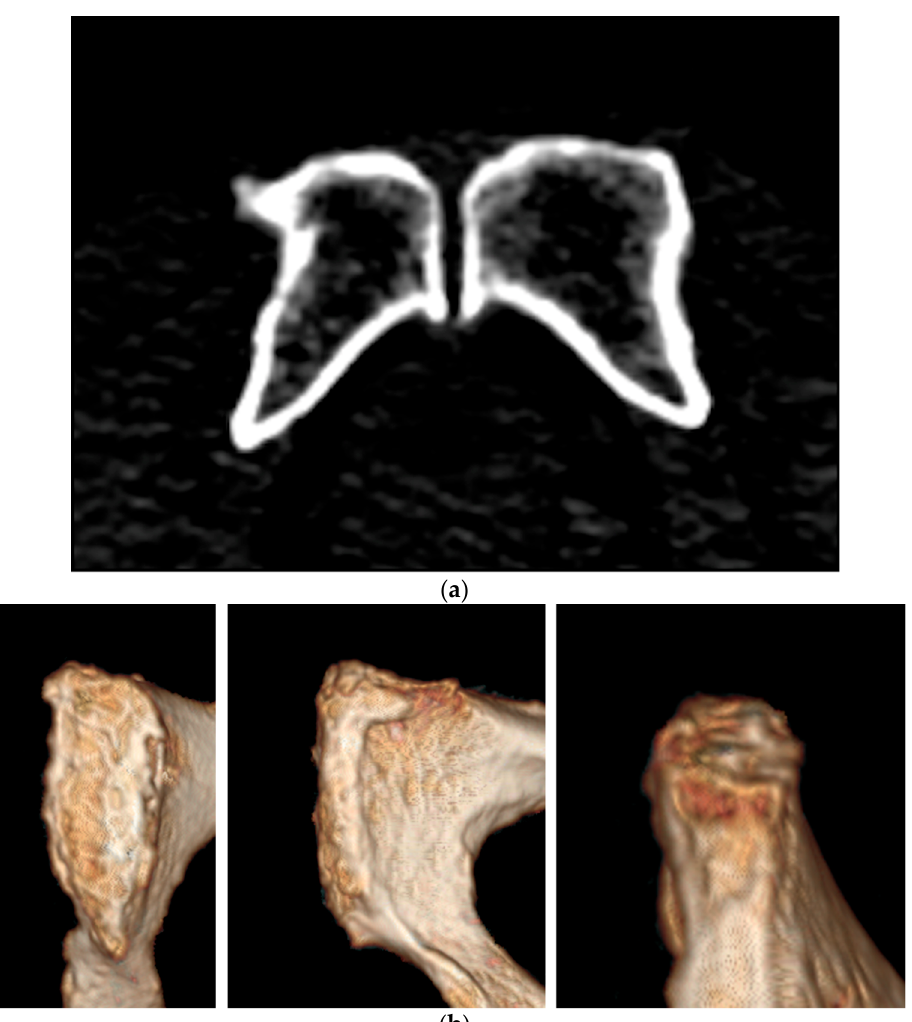
Figure 15. ( a ) Example axial view. ( b ) Example anterior, lateral, and inferior views .